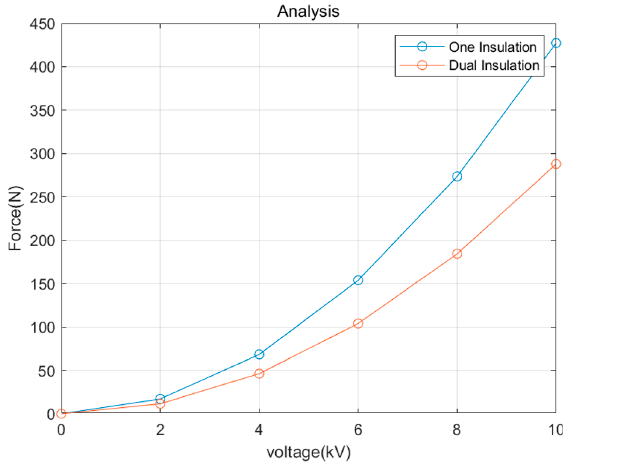
Figure 2. Comparison of experimental and analysis data of the single-insulation pad structure and the dual-insulation pad structure electroadhesion pad: ( a ) analysis data; ( b ) experimental data.